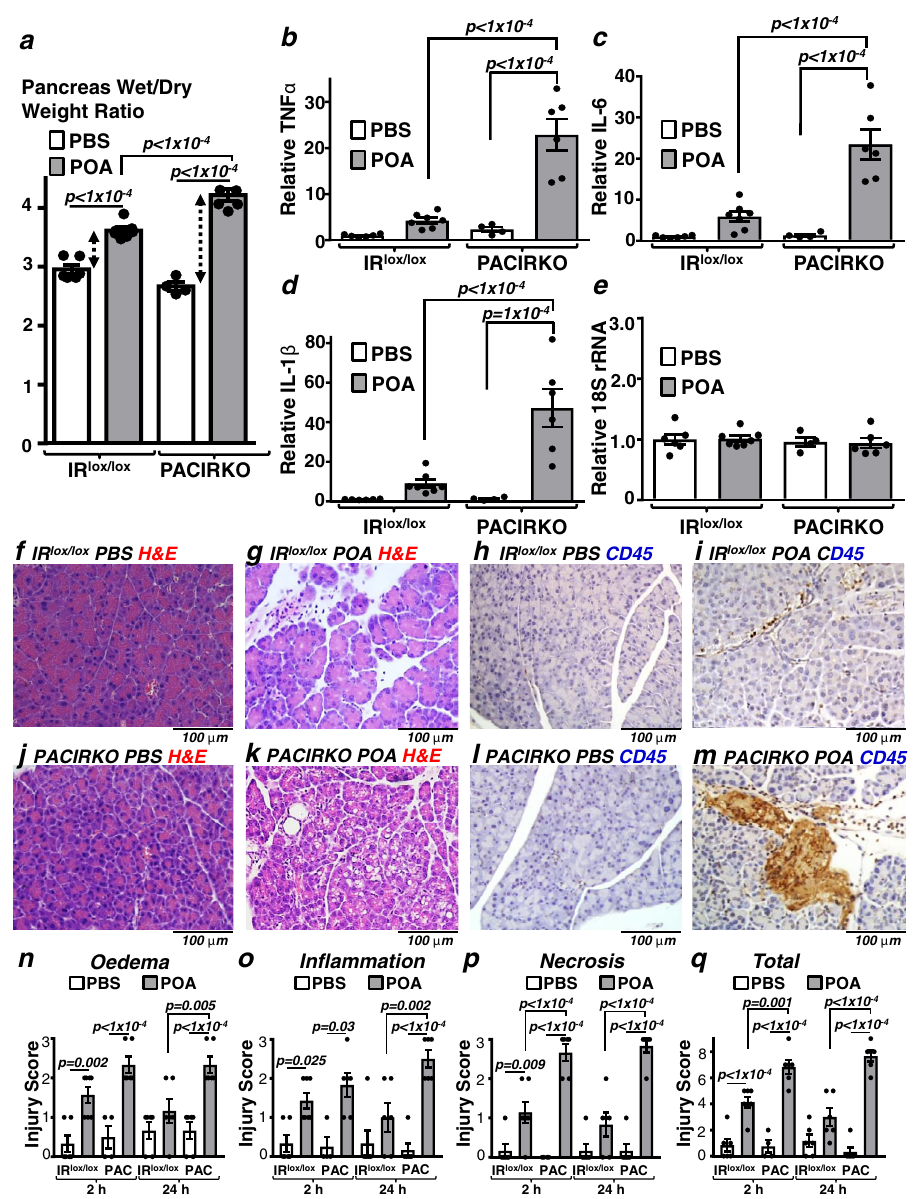
Fig. 4 POA/ethanol-induced pancreatitis was more severe in PACIRKO vs IR lox/lox mice. Pancreatitis was induced in IR lox/lox and PACIRKO mice by 2 hourly IP injections of 100 µ g/Kg POA in ethanol (0.8 g/Kg) or corresponding PBS control and blood/tissue was harvested 2 and 24 h after the last injection. Multiple readouts of pancreatitis include; pancreatic tissue oedema (wet/dry weight ratio, a ), cytokine expression (qPCR of tissue mRNA; TNF α , b ; IL-6, c , IL-1 β , d ; and the housekeeping 18S rRNA, e ), histological signs of injury (haematoxylin and eosin (H&E), f , g , j and k ), immunohistochemistry of the in fl ammatory marker, CD45 (brown) ( h , i , l and m ). n – q Histology injury scores (where 3 is the most severe) for oedema ( n ), in fl ammatory cell in fi ltration ( o ), necrosis ( p ), and total score ( q ; sum of other scores). Group sizes were: 2 h harvest, IR lox/lox PBS, n = 6; IR lox/lox POA, n = 7; PACIRKO PBS, n = 4; PACIRKO Caer, n = 6; 24 h harvest, IR lox/lox PBS, n = 6; IR lox/lox Caer, n = 6; PACIRKO PBS, n = 6; PACIRKO Caer, n = 6 Signi fi cance (exact p values as indicated) was determined by one-way ANOVA with Sidak ’ s multiple comparisons. Data are presented as mean value ±